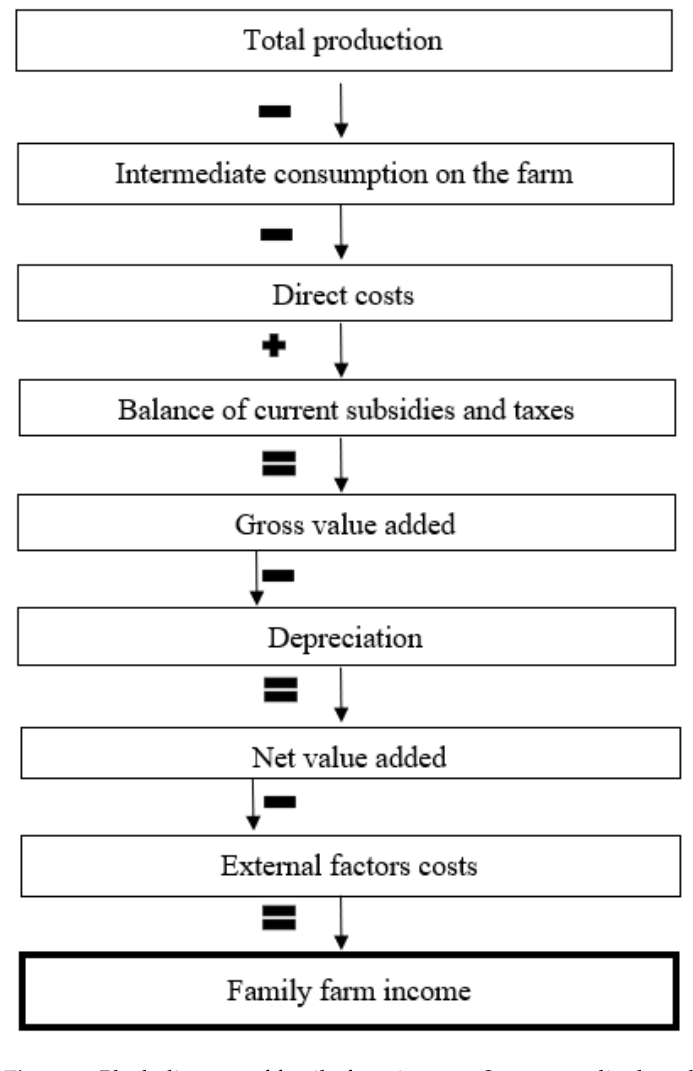
Figure 1. Block diagram of family farm income. Source: studies based on [40]. Crop production includes sales, internal consumption, handing over to the household and the inventory difference for all animals products on the farm. This was measured in PLN [40]. The total production value, gross value added, net value added and agricultural income were determined for the analyzed farms. The farm income was calculated according to the scheme shown in Figure